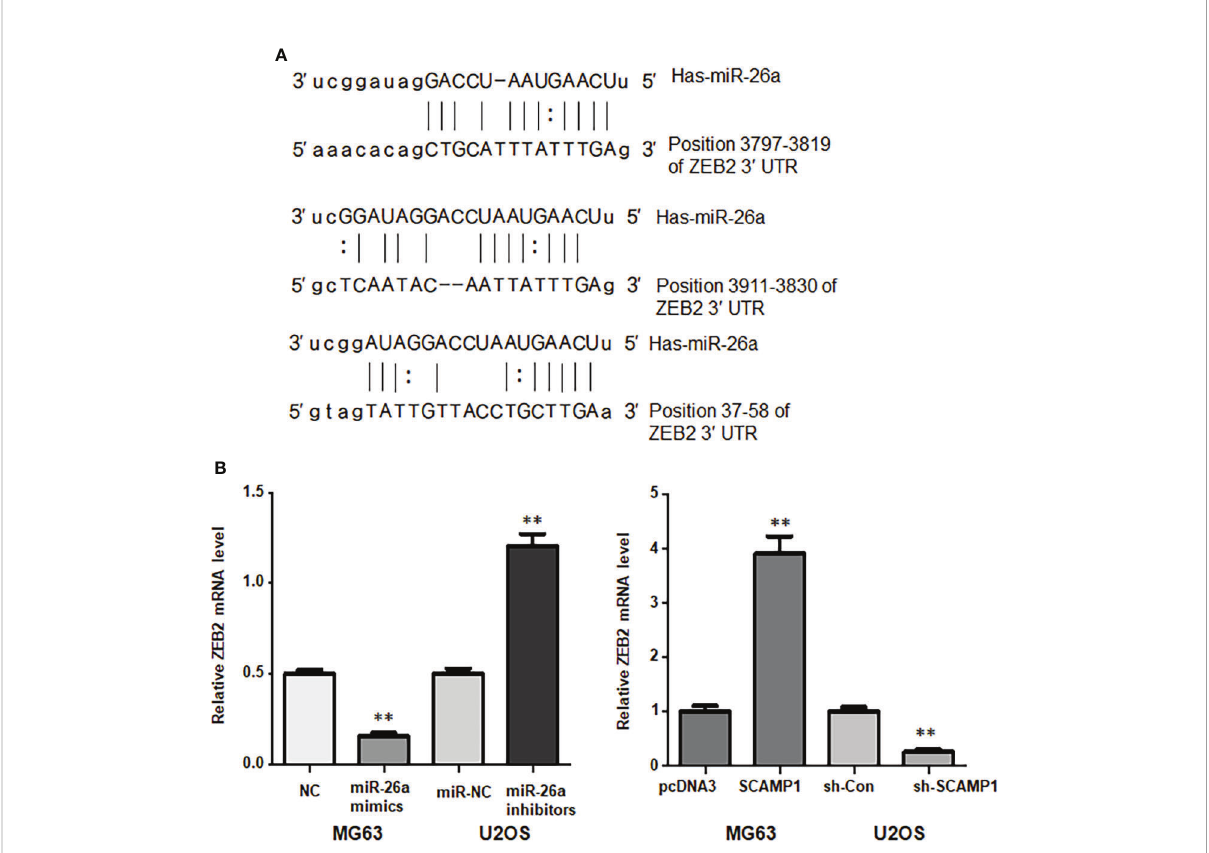
FIGURE 6 ZEB2 is a downstream target of miR-26a-5p in osteosarcoma cells. (A) : The potential binding sites between miR-26a-5p and ZEB2. (B) : Left panel: RT-PCR data showed that miR-26a-5p mimics attenuated the mRNA levels of ZEB2 in MG63 cells. miR-26a-5p inhibitors elevated ZEB2 mRNA levels in U2OS cells. Right panel: RT-PCR data showed that SCAMP1-overexpressing cells had the high expression of ZEB2 in MG63 cells. In shR-SCAMP1 transfected U2OS cells, ZEB2 mRNA levels were remarkable downregulated. **p<0.01 vs. control